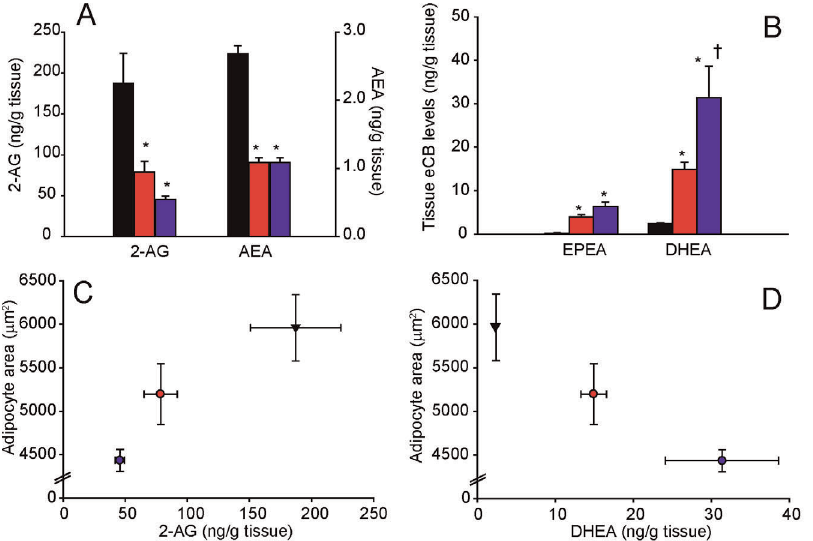
Figure 6. Modulation of adipose tissue levels of endocannabinoids and endocannabinoid-like molecules by dietary LC n -3 PUFA in the ‘reversal study’. Following a 4-month-period of cHF-feeding, mice were fed for additional 9 weeks cHF diet, or treated using either cHF + v 3TG or cHF + v 3PL diet supplemented with 30 g DHA/EPA per kg; all diets also contained 2 g metformin per kg. The effects of LC n -3 PUFA supplementation on adipose tissue levels of 2-arachidonoylglycerol ( 2-AG ) and anandamide ( AEA; A ), as well as on the levels of N - eicosapentaenoylethanolamine ( EPEA ) and N -docosahexaenoylethanolamine ( DHEA; B ); cHF, black bars; cHF + v 3TG, red bars; cHF + v 3PL, blue bars. The relationship between adipocyte size and adipose tissue levels of either 2-AG ( C ) or DHEA ( D ) in mice fed cHF (black triangles), cHF + v 3TG (red circles), or cHF + v 3PL (blue circles) diet. Data are means 6 SEM ( n =8–9). *Significantly different from cHF (t-test or ANOVA); { significantly different from cHF + v 3TG